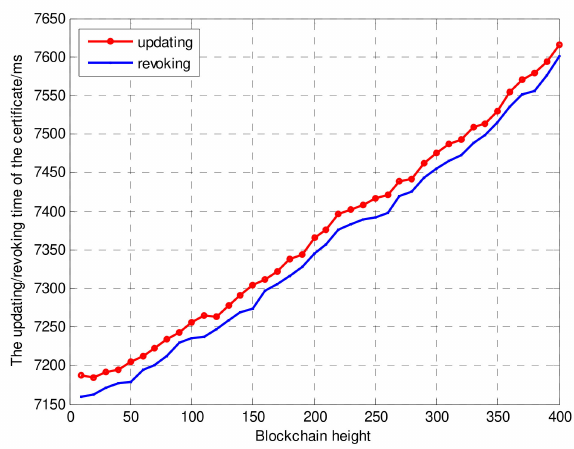
Figure 11. The updating and revoking delays for